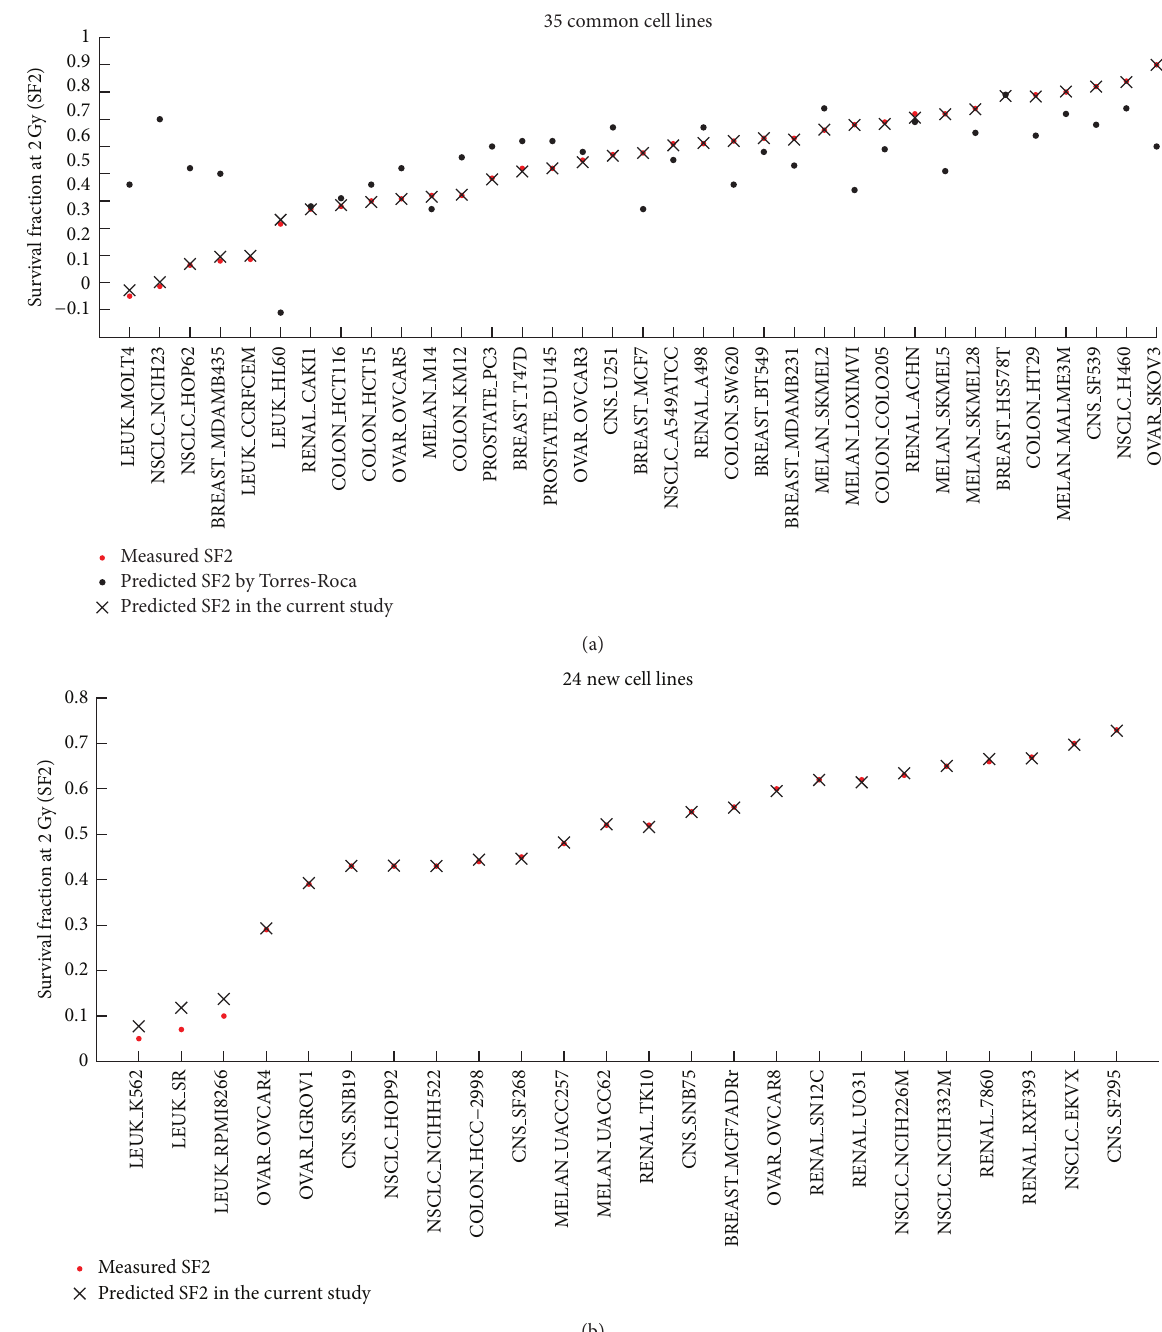
Figure 2: The measured and predicted SF2s of NCI-60 obtained by our method and by the model of Torres-Roca et al. Note: among 59 cancer cell lines used in the current study, only 35 were included in the study of Torres-Roca et al. (Figure 2(a)).